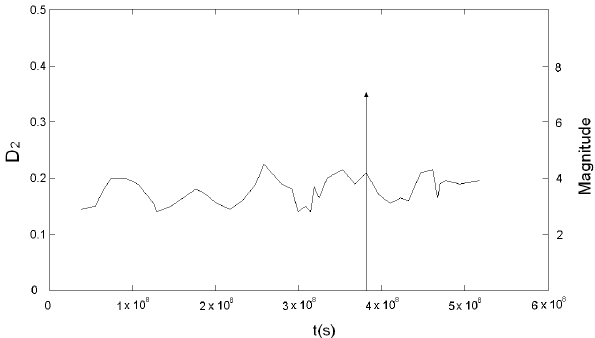
Fig. 6. The generalised dimension spectrum D q for q ranging between − 5 and 5.